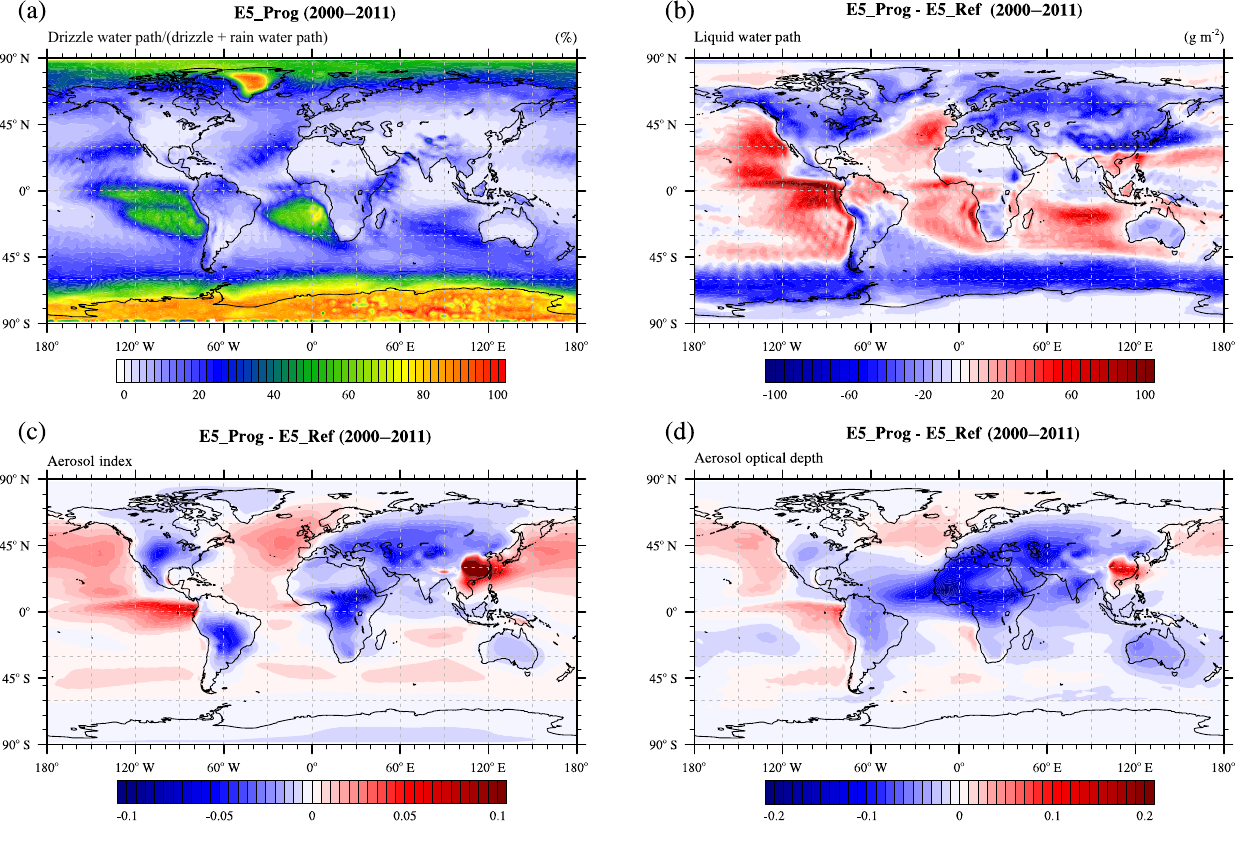
Figure 7. (a) Annual mean ratio of drizzle water path to the sum of drizzle and rain water path for the E5_Prog simulation. The difference between E5_Prog and E5_Ref for 12 years of simulations (2000–2011) (b) LWP, (c) AI, (d) AOD. Panel (a) and (b) include precipitation and LWP from all clouds, not only low liquid clouds, (c) and (d) include cloudy and cloud-free